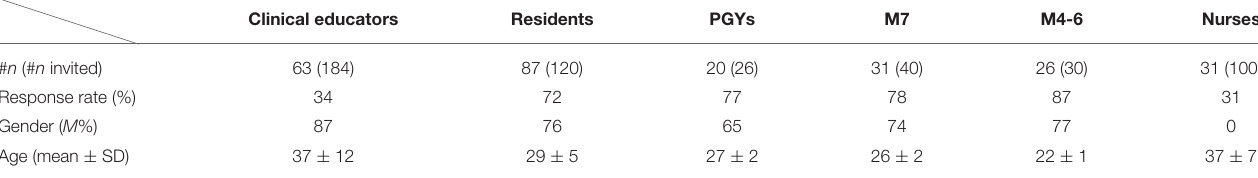
TABLE 1 | Demographic information of respondents.